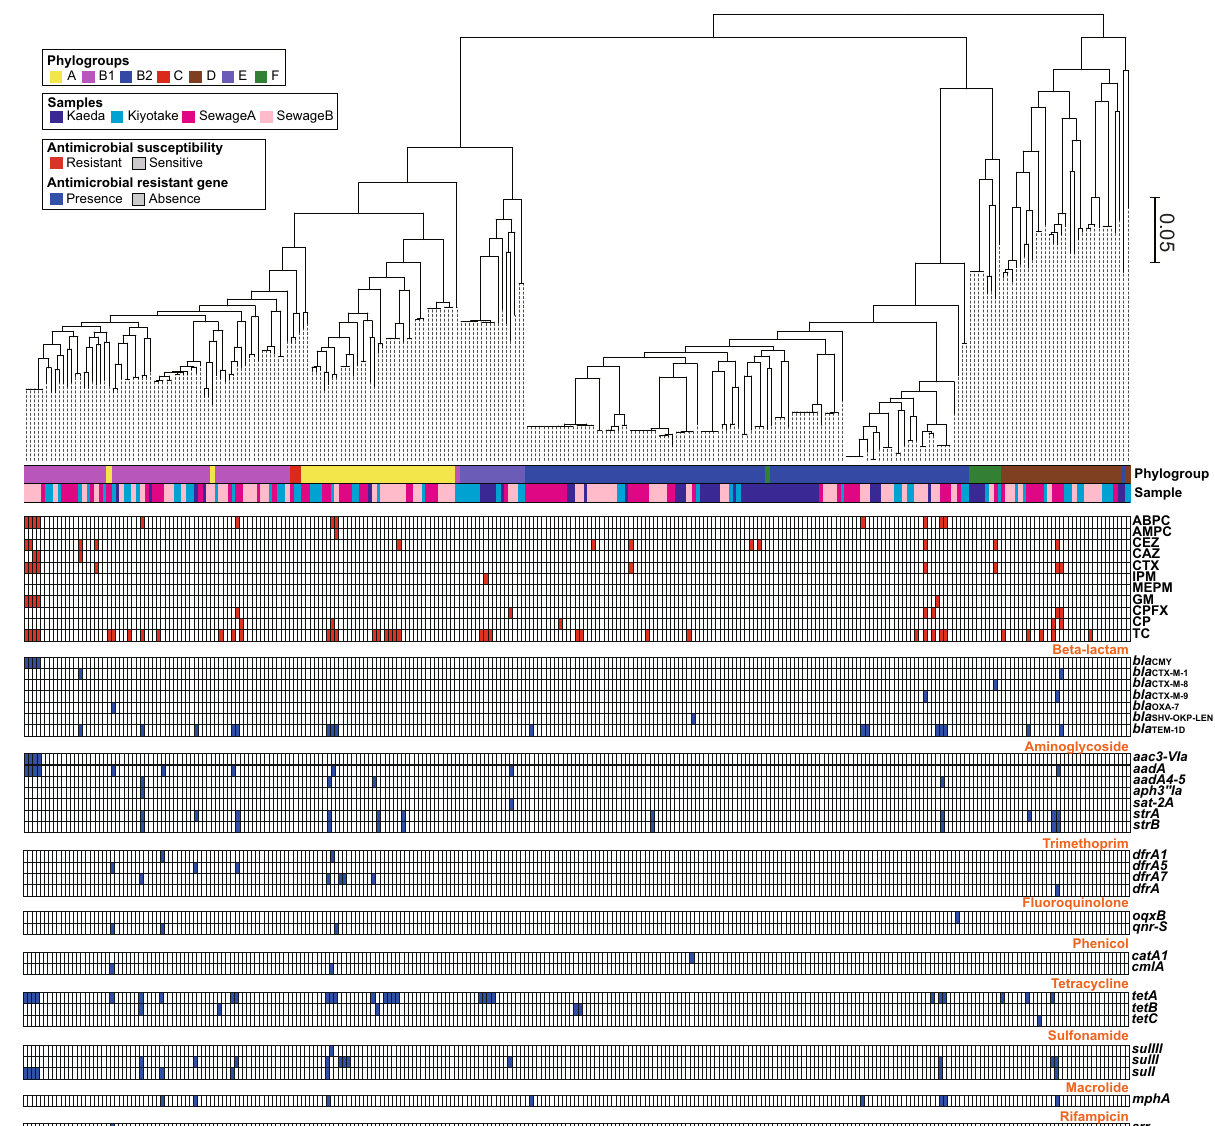
Figure 3. Whole-genome-based tree of 283 E. coli strains with phenotypic antimicrobial resistance and the presence of acquired antimicrobial resistance genes. An ML tree was constructed based on 329,863 SNP sites on 2,277 core genes. The phenotypic antimicrobial resistance and the presence of acquired antimicrobial resistance genes are indicated by red and blue,